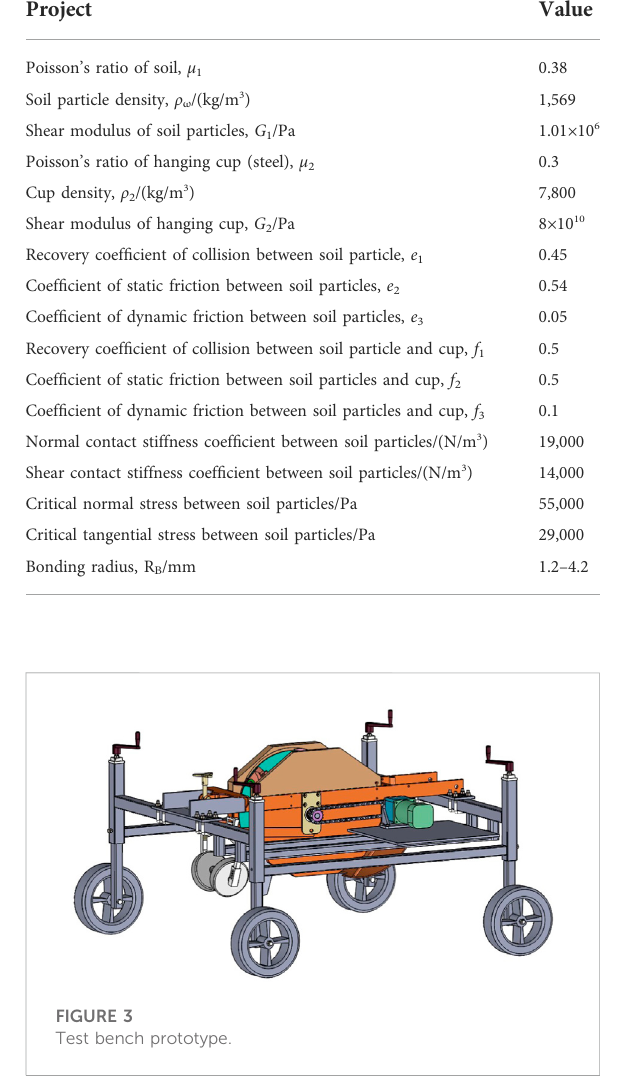
Table 5. Motion 1 is the motion relationship between the Earth and the frame. Motion 2 is the motion relationship between the central axis and the bearing roller. Motion 3 is the motion relation between the central axis and the eccentric disc. The virtual prototype model after setting is shown in Figure 4.